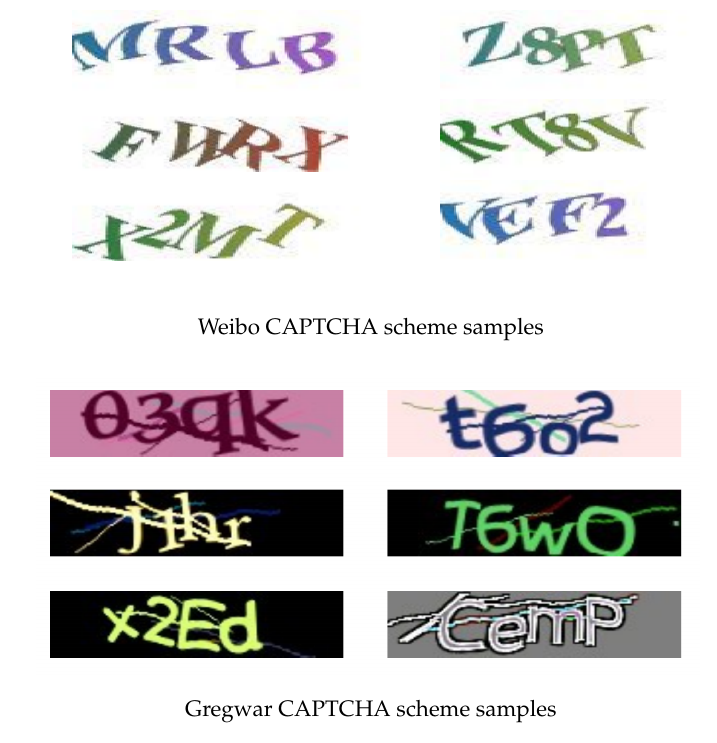
Figure 6. Samples of CAPTCHA images